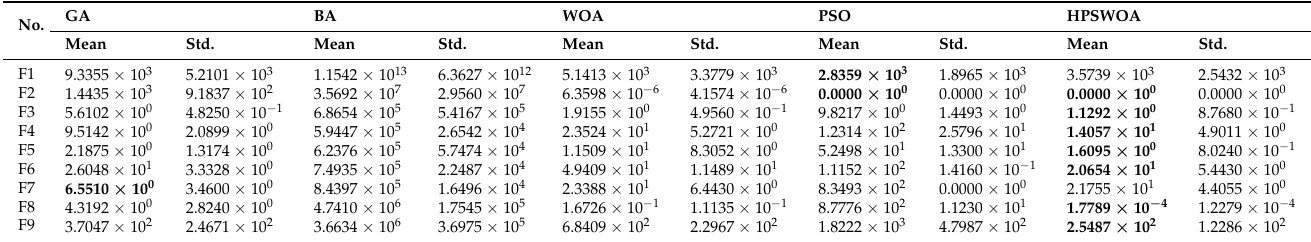
Table 3. Comparative results for the CEC 2017 benchmark